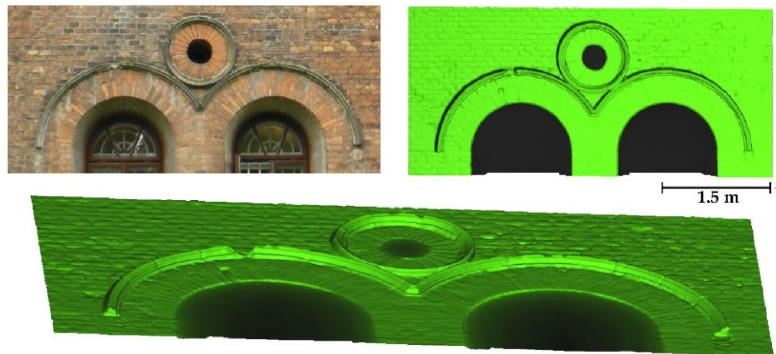
Figure 4. Three ‐ dimensional model of the cornice. Figure 4. Three-dimensional model of the cornice.